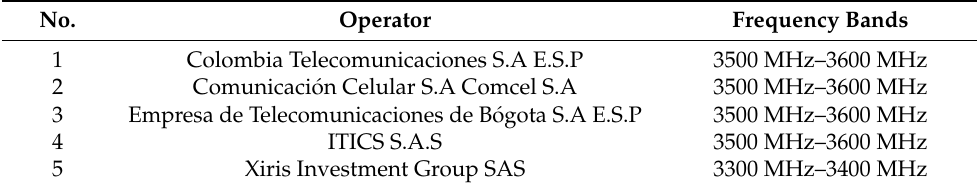
Table 3. Operators assigned for 5G pilot in Colombia.